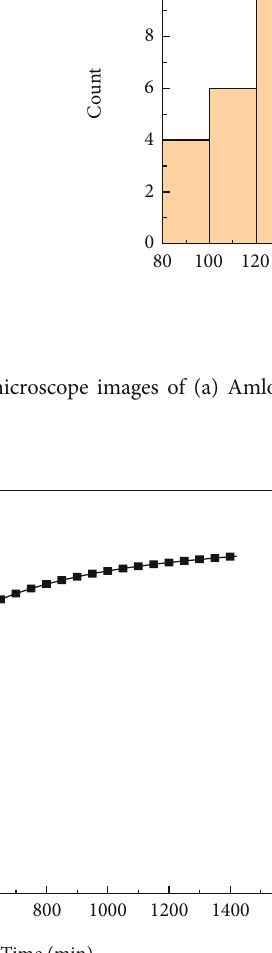
Table S1: the raw data which collected from lab work; Table S2 the R 2 values for the three models; Table S3 regression equations for the LE, particle size and zeta potential models; Figure S1 normal probability plots for %LE (A), particle size (B), and zeta potential (C). Figure S2 residual versus order of model for %LE (A), particle size (B), and zeta potential (C). Figure S3 residuals versus fi ts of model for %LE (A), particle size (B), and zeta potential (C). Figure S4 contour and sur- face plots for % LE against Fe 3+ , Al 3+ , pH and polymer var- iables; Figure S5 contour plots and surface plots for particle size against Fe 3+ , Al 3+ , pH and polymer variables; Figure S6 contour plots and surface plots for zeta potential against Fe 3+ , Al 3+ , pH and polymer variables. (Supplementary Materials)